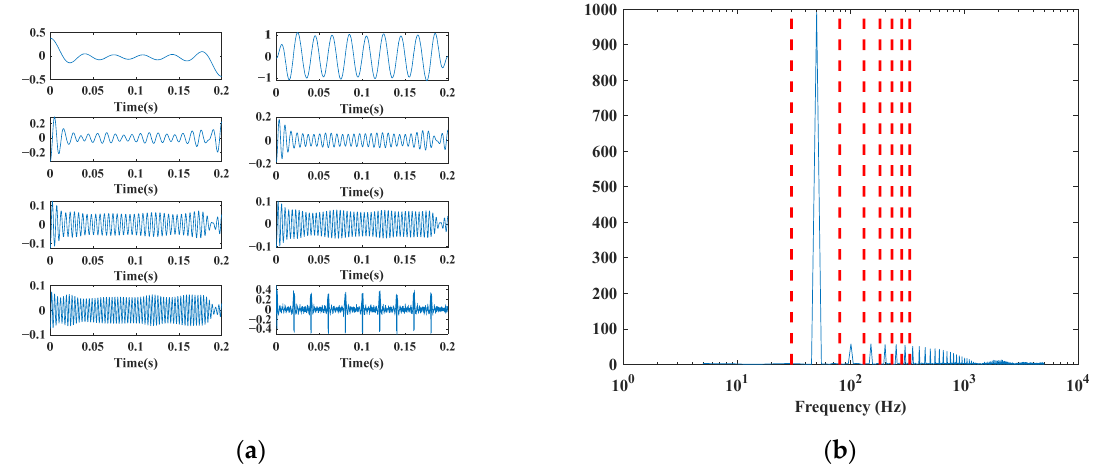
Figure 12. Periodic notch decomposition results by EWT when K = 8. ( a ) Results in the time domain; ( b ) Results in the frequency domain.